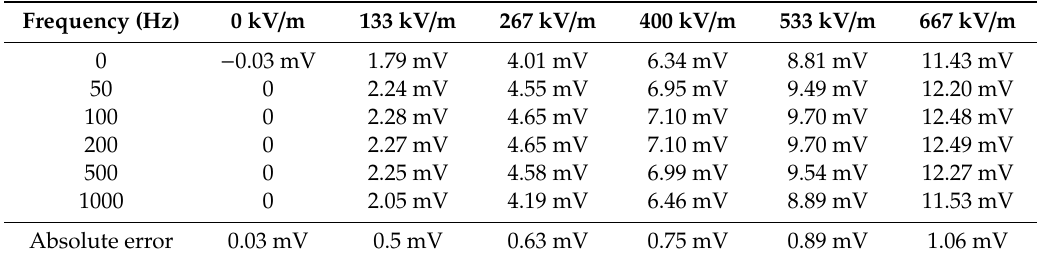
Table 3. The detailed test data of the EFM frequency characteristics under di ff erent electric